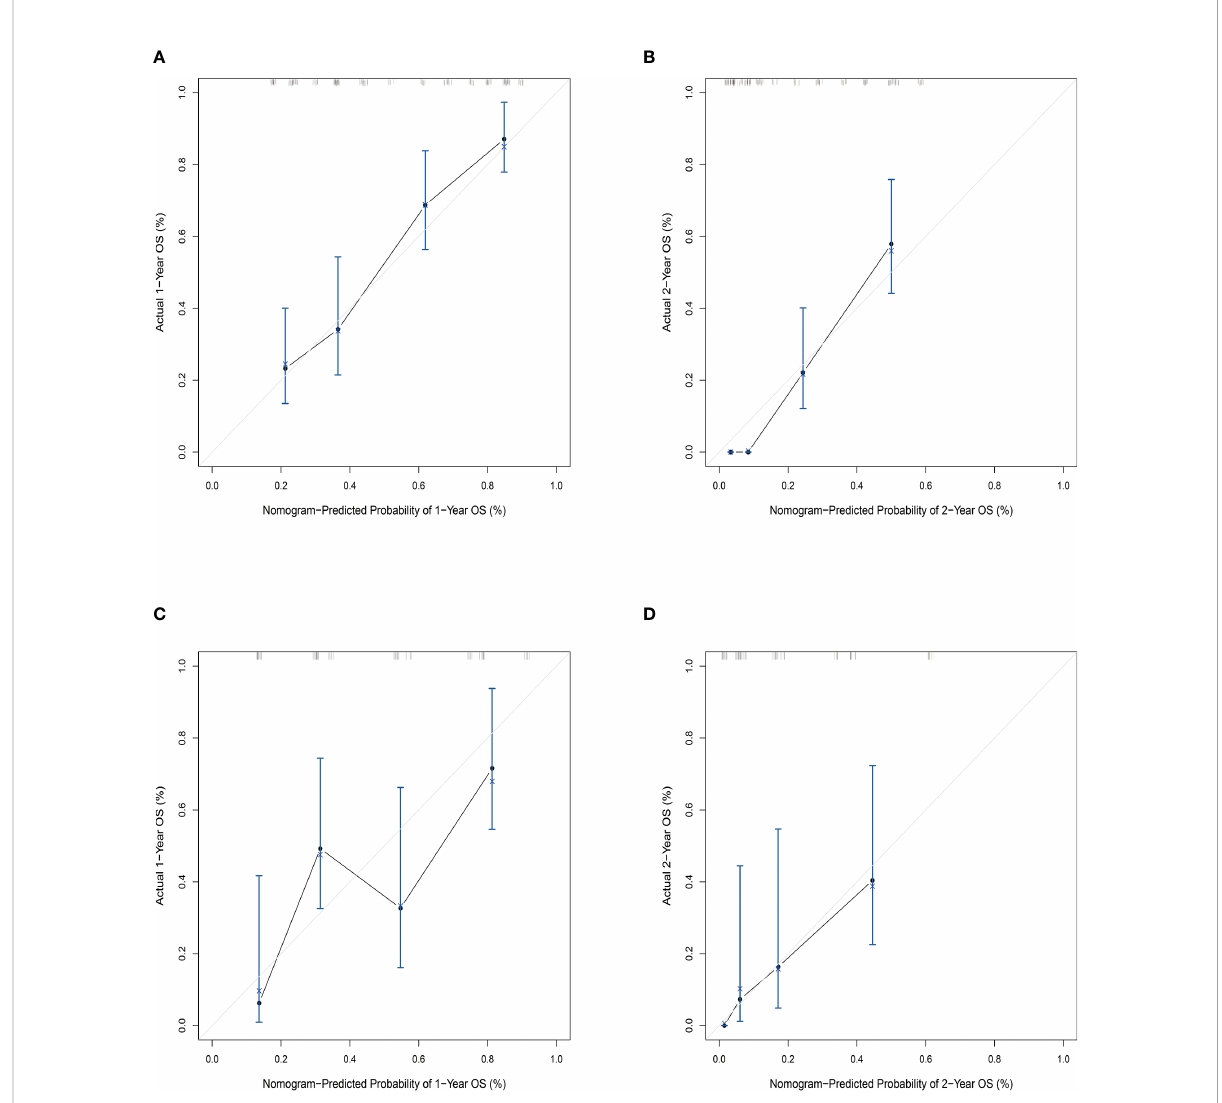
FIGURE 4 Calibration plot of the nomogram model comparing predicted probabilities with actual 1- and 2-year survival rates. (A) Calibration plot of 1-year survival prediction in the training set nomogram; (B) calibration plot of 2-year survival prediction in the training set nomogram; (C) calibration plot of 1-year survival prediction in the validation set nomogram; (D) calibration plot of 2-year survival prediction in the validation set nomogram. The c-index in the training set is 0.745, and in the validation set, it is